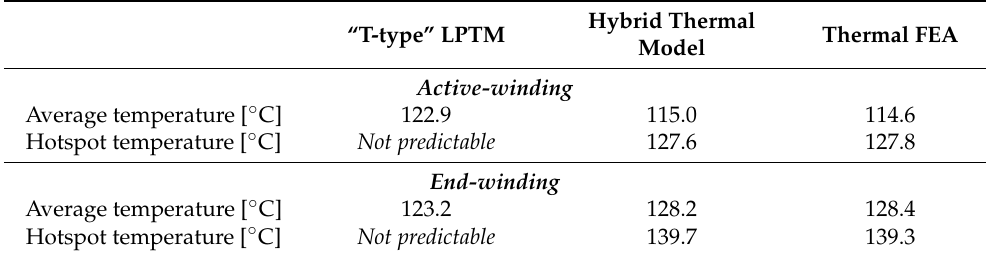
Figure 25. Steady-state winding temperature distributions predicted by ATMs and FEA [66]. ( a ) Active-winding (analytical). ( b ) Active-winding (FEA). ( c ) End-winding (analytical). ( b ) End-wind- ing (FEA). Table 5. Comparison of steady-state average and hotspot temperatures of active-/end-windings predicted by main thermal analysis methods [66].